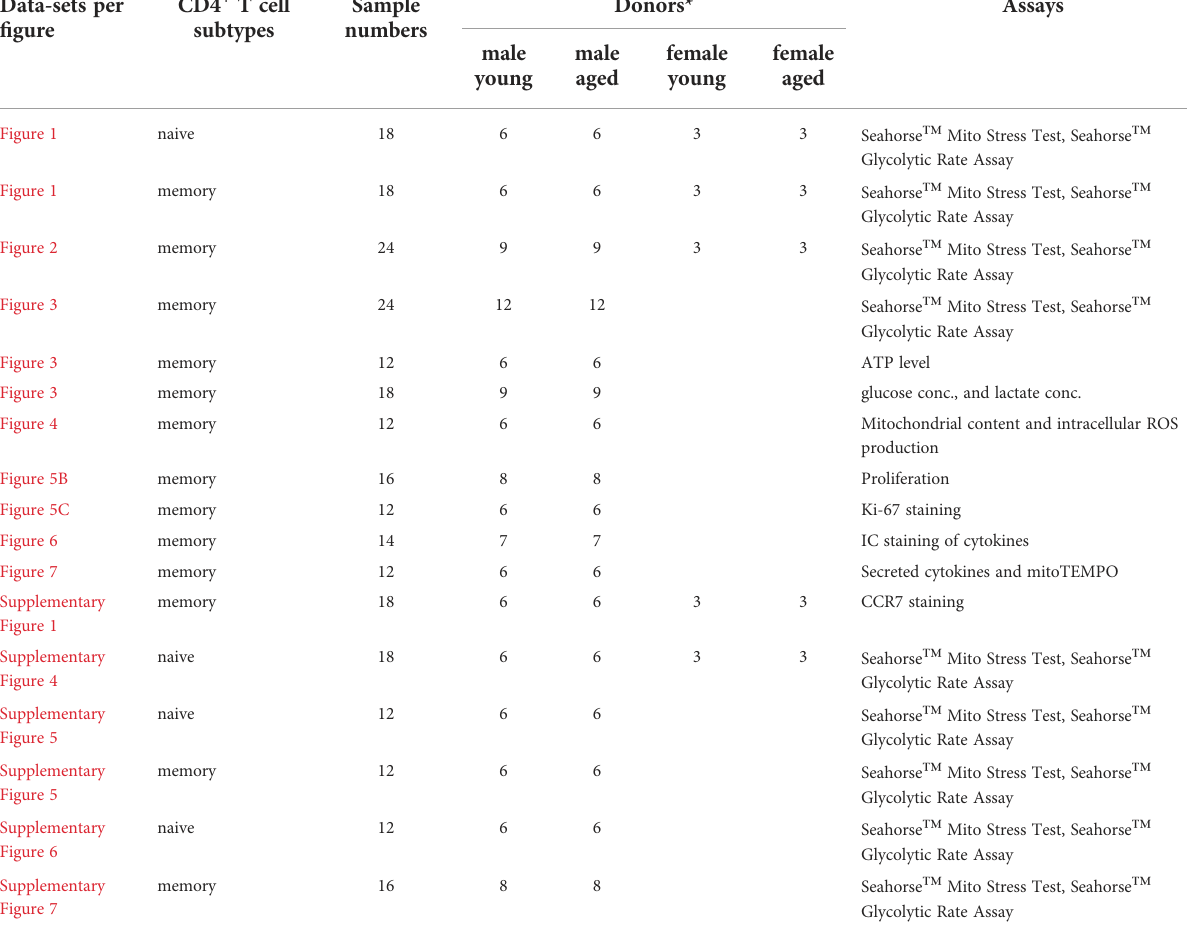
TABLE 1 Characteristics of young and aged donors as analyzed using metabolic measurements. Data-sets per fi gure